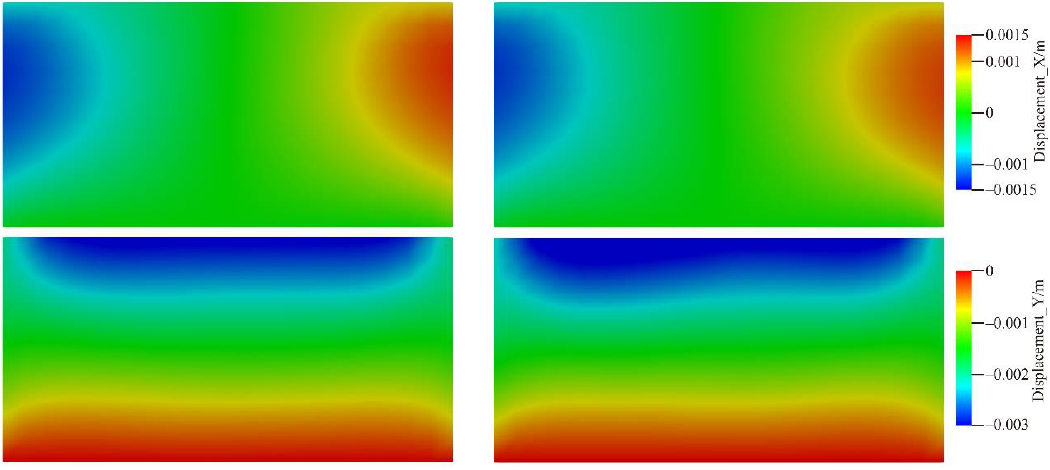
Figure 12. Horizontal ( a , b ) and vertical ( c , d ) displacements of two realisations when the coefficient of friction is 0.